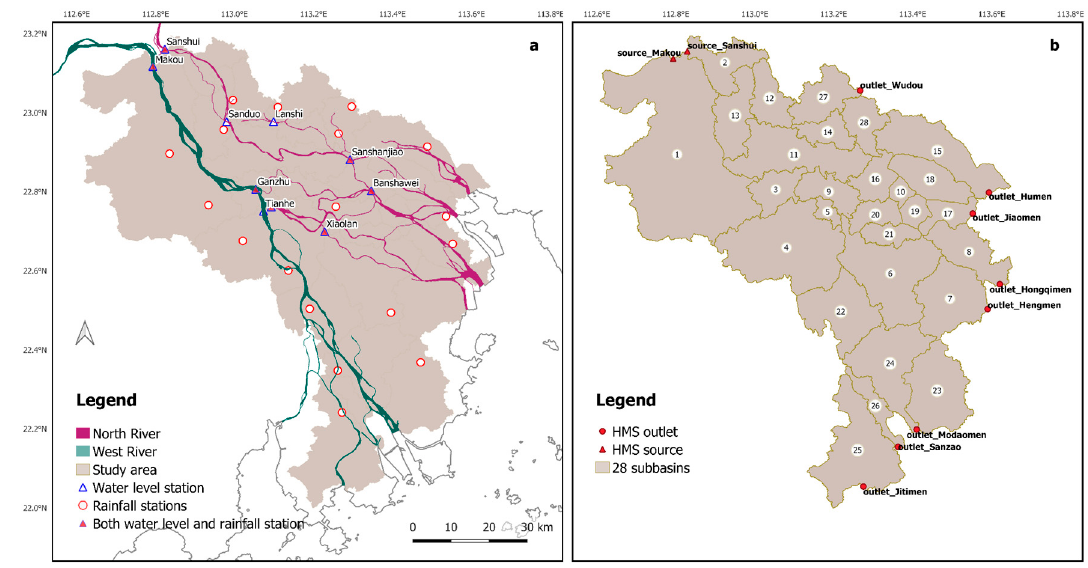
Figure 2. ( a ) Location of key rainfall, river discharge and water level gage stations, and ( b ) Hydrologic Engineering Center’s Hydrologic Modeling System (HEC-HMS) model configuration which details the 28 sub-basins in the HEC-HMS’s basin model with two sources and eight